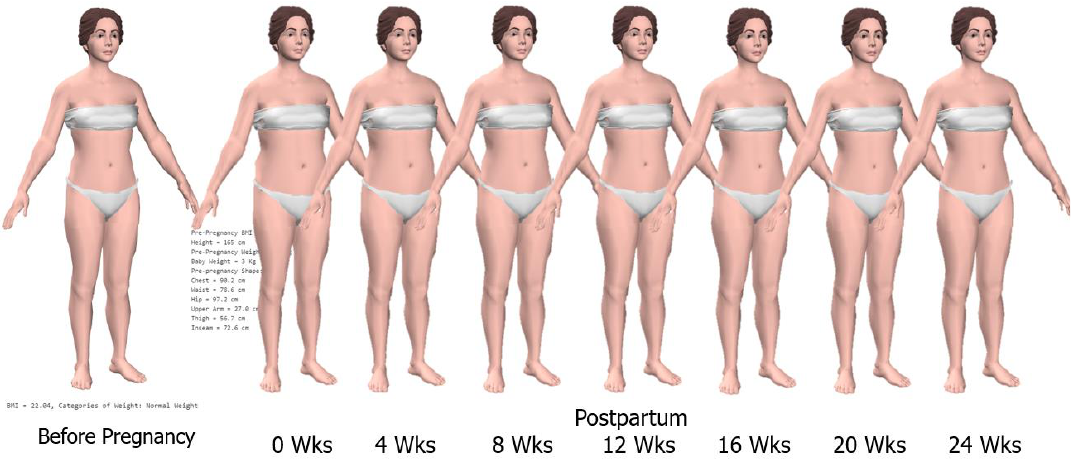
Figure 6. 3D simulation models of postpartum women.